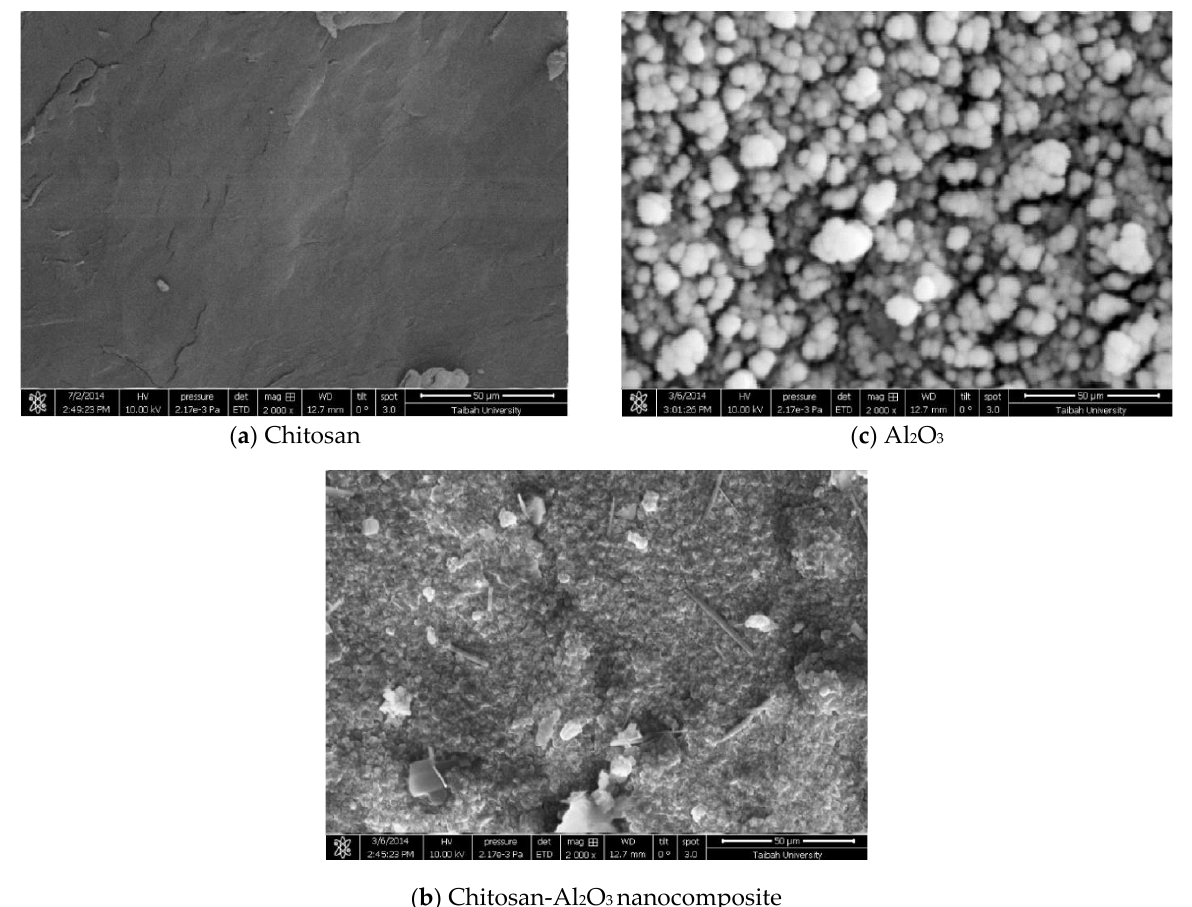
Figure 3. Emission Scanning Electron Microscopy ( ESEM) of ( a ): chitosan and ( b ): chitosan-Al 2 O 3 nanocomposites as compared to that of Al 2 O 3 ( c ).